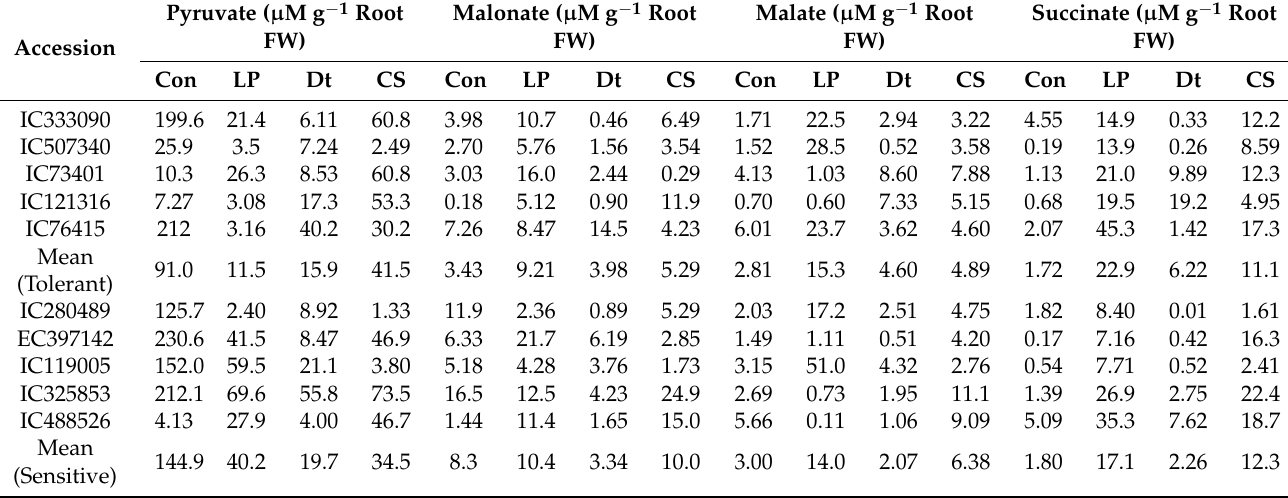
Table 4. Effect of P nutrition and drought on exudation of organic acid (pyruvate, malonate, malate, and succinate) from roots of selected mungbean accessions grown at two P levels (sufficient, 25.6 mg P kg − 1 dry soil, and low P, 7.8 mg P kg − 1 dry soil) and two moisture regimes (irrigated and drought). Con—Control; LP—Low phosphorus; Dt—Drought; CS—combined stress.